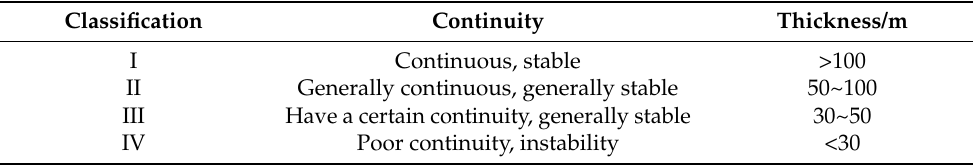
Table 2. Thickness classification of gas storage caprock of depleted oil and gas reservoir.